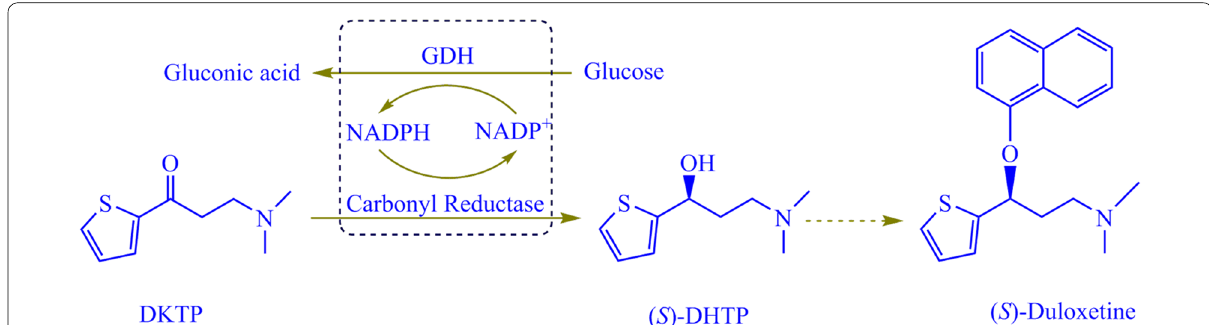
Fig. 1 Scheme for ( S )-duloxetine synthesis from bioreduction of DKTP to ( S )-DHTP involving fusion-based enzyme-coupled